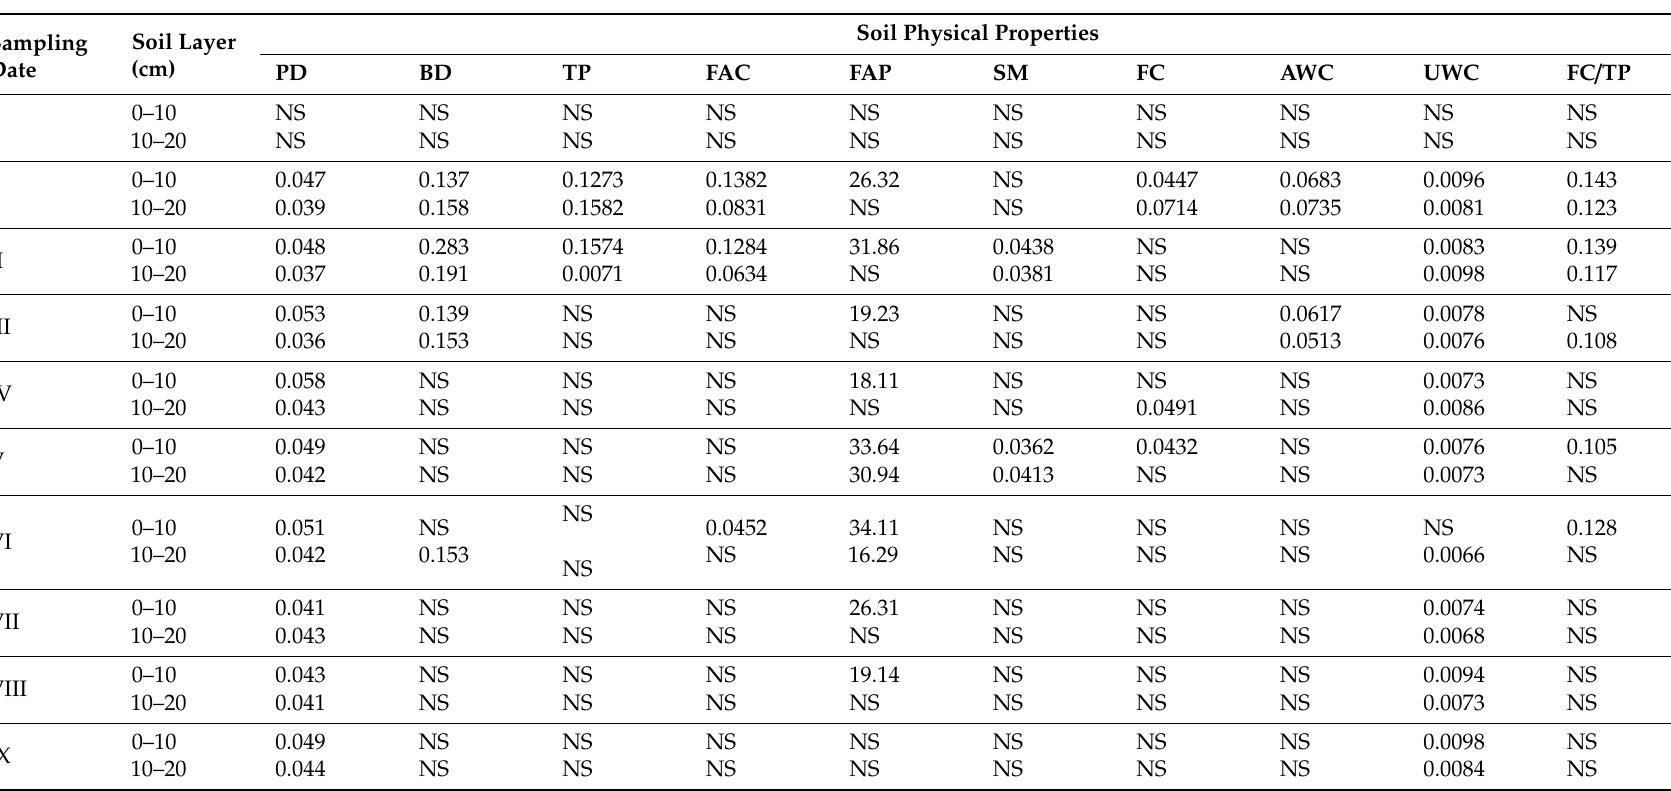
Table 1. The lowest significant di ff erences (LSD 0.05 ) between treatments (BC0, BC10, BC20 and BC30) for dates sampling (0-IX) and studied layers (0–10 cm and 10–20